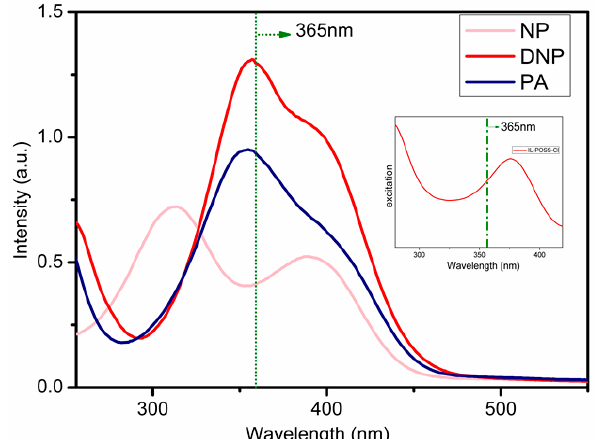
Figure 5. UV–vis absorption spectra of various analytes in ethanol and the excitation spectrum of IL-POSS-Cl in an ethanol suspension.